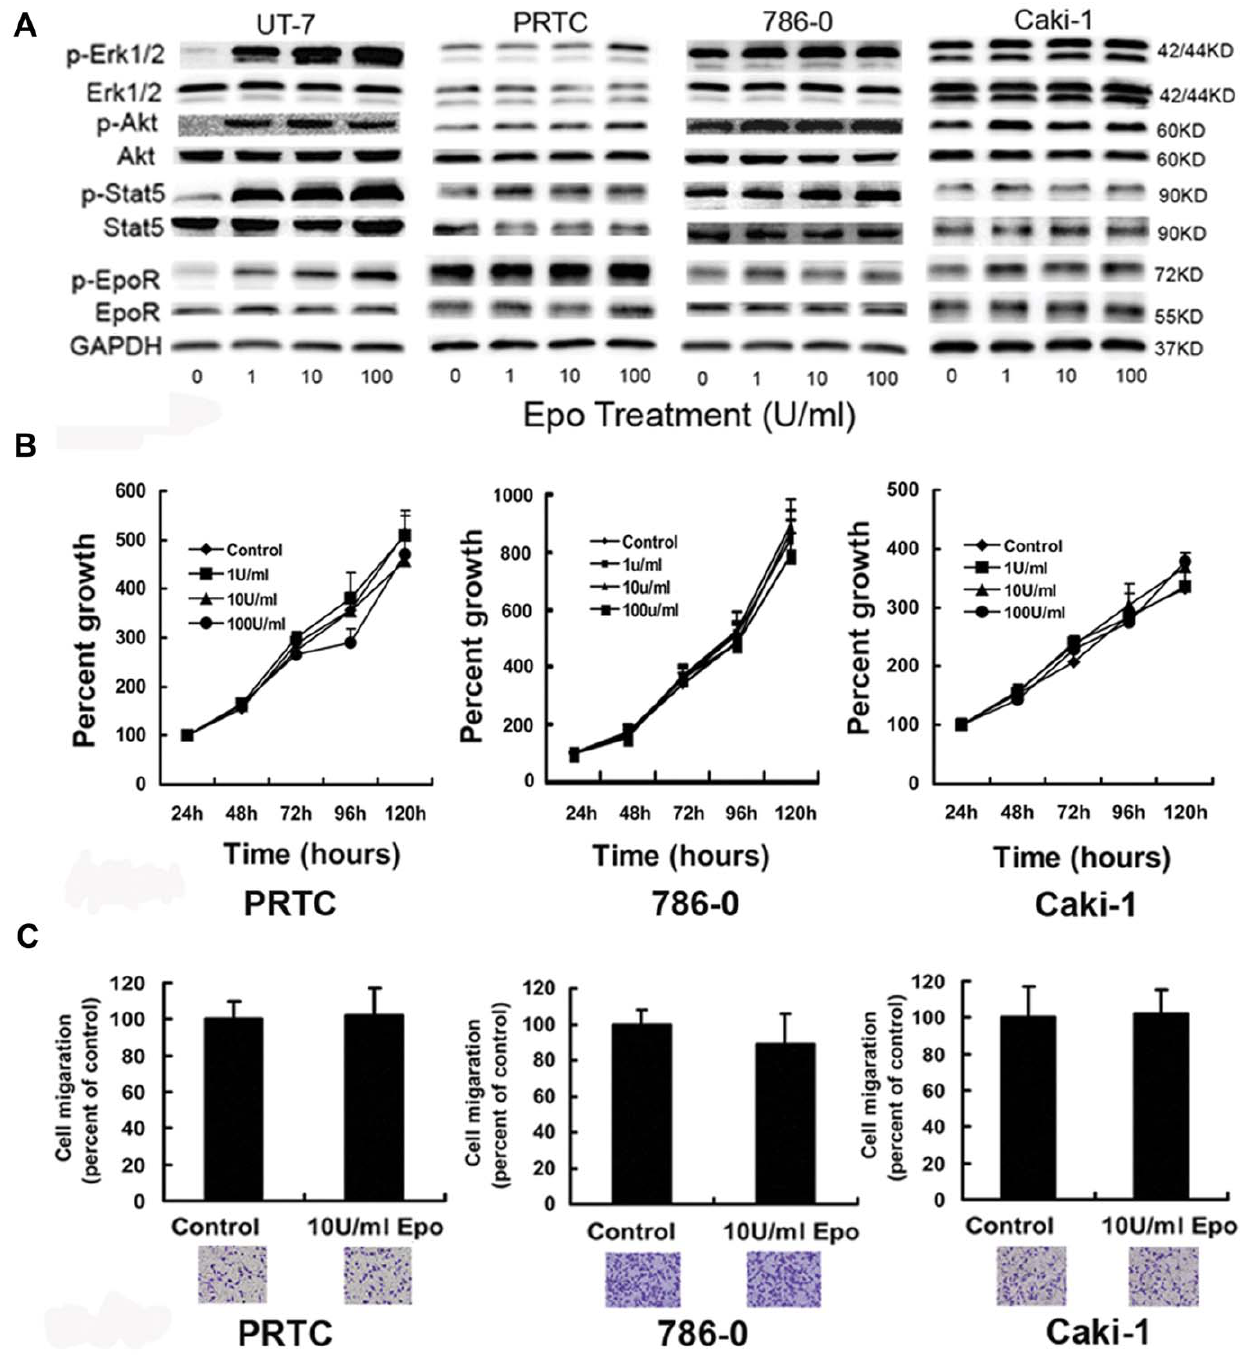
Figure 2. Exogenous Epo shows no biological effect on signaling molecules, proliferation, and invasion ability in RCC cells. (A) RCC cells were treated with 0–100 U/ml Epo for 5 min after serum starvation for 24 hours. Compared with Epo-dependent UT-7 cells, the phosphorylation of EpoR, STAT5, Akt and Erk1/2 in PRTC, 786-0 and Caki-1 cells increased insignificantly, if any, after rhEpo stimulations. Moreover, RCC cells expressed higher levels of baseline phosphorylation of all examined EpoR signaling proteins than UT-7 cells in the absence of exogenous Epo. In UT-7 cells, p- EpoR, p-STAT5, p-Erk1/2 and p-Akt were at lower levels before Epo stimulation, and increased significantly at 1 U/ml Epo. Experiments were done in triplicate with similar results. (B) PRTC, 786-0 cells and Caki-1 cells were cultured in media containing 0, 1, 10 and 100 U/ml Epo after serum starvation for 24 hours. Viable cells were evaluated after various incubation periods by modified MTT assay. Exogenous Epo had little effect on proliferation of RCC cells (6 wells for one sample, and experiments in triplicate; P . 0.05 by one-way ANOVA). (C) Transwell tests for invasion ability of PRTC, 786-0 cells and Caki-1 cells. Upper chamber: 2 6 10 4 RCC cells in serum-free medium with 0-100 U/ml concentrations of Epo; lower chamber: medium containing 10% FBS. Cells were stained and counted after incubation for 36 hours. Error bar represents mean 6 SD (n=3). There is no difference between RCC cells with Epo and those without Epo in medium (only showing 10 U/ml groups).